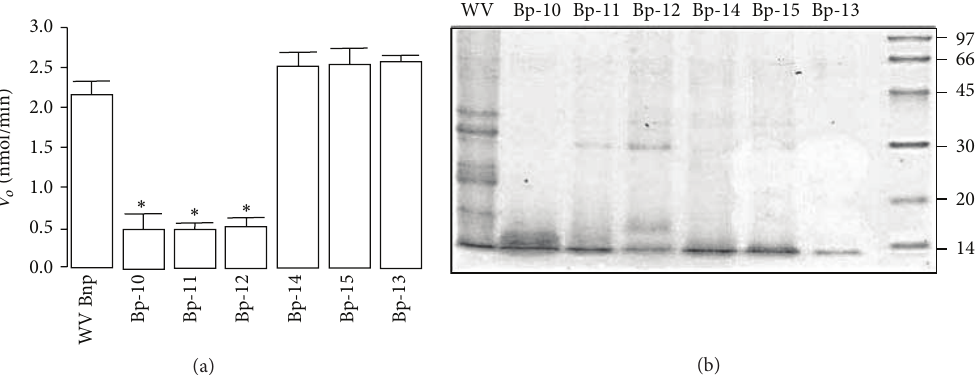
Figure 2: (a) PLA 2 activity of Bothrops pauloensis whole venom (WV), Bp-13 PLA 2 . ANOVA and followed by Mann-Whitney test for comparison between two groups. Data are represented as mean ± SEM. (b) SDS-PAGE profile of Bp-13 PLA 2 , Mm, molecular mass markers ( × 10 −3 ).